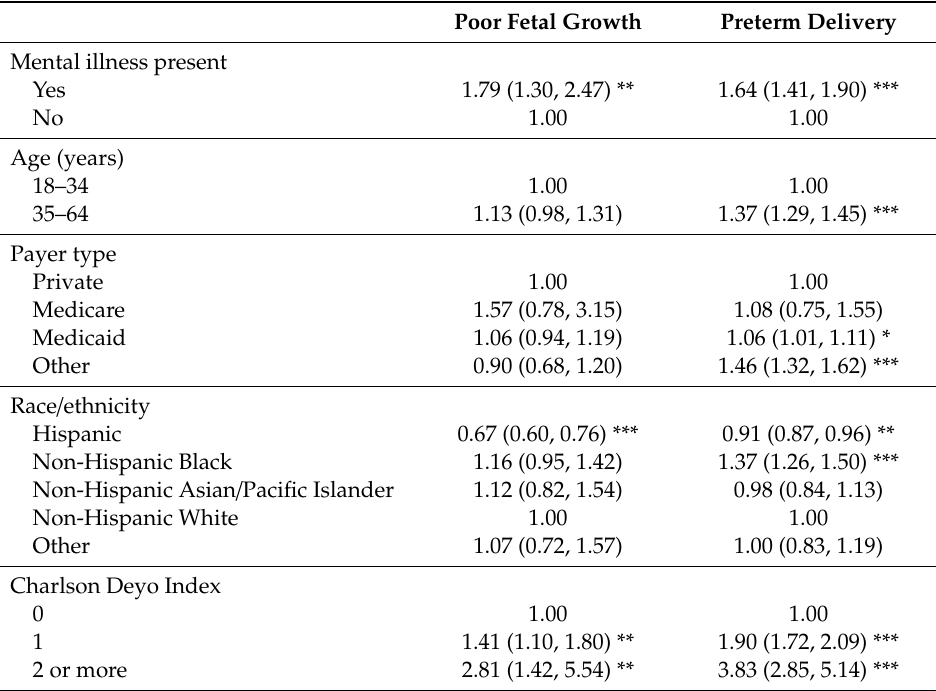
Table 2. Odds ratio (and 95% CI) of poor fetal growth and preterm delivery in the South East Desert / Inland Empire region of